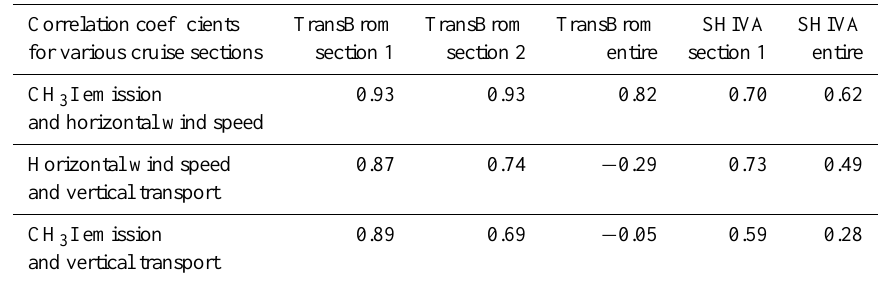
Fig. 4. The CH 3 I observed emissions (line) and the modeled relative amount entrained above 17km (dots) are shown for TransBrom (a) and SHIVA (b) as a function of time (left panels) and as a scatter plot (right panels). The subsets, for which correlations between the two functions have been identified, are color-coded in red and blue. The correlation coefficients ( r ) are given in the right panel. Table 4. Correlation coefficients between CH 3 I emission, horizontal wind speed and vertical transport efficiency (given by the relative amount of CH 3 I entrained above 17km). The coefficients are given for the entire TransBrom and SHIVA campaigns as well as for the subsets where correlations between the CH 3 I emissions and vertical transport efficiency have been identified (TransBrom section 1 and 2, SHIVA section